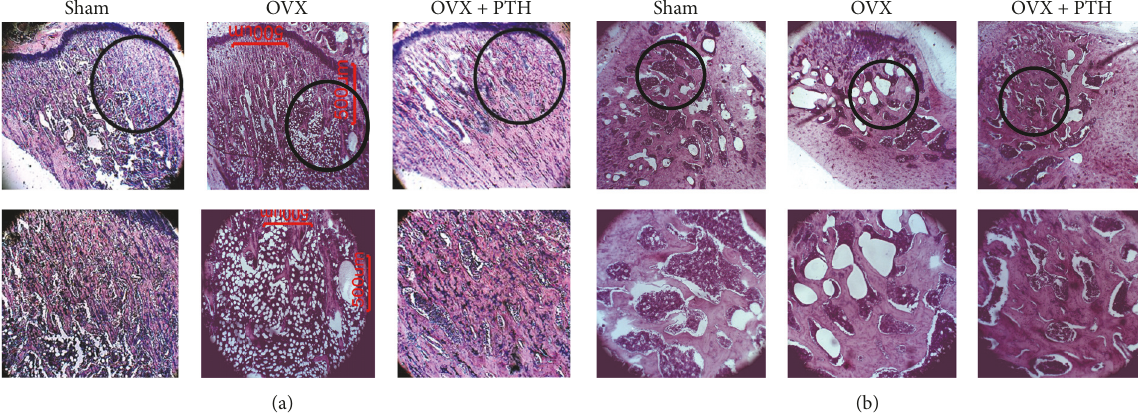
Figure 3: Prevention experiment reference measurements: examples of bone marrow cellularity histology (hematoxylin and eosin stain) of Sham, OVX, and OVX + PTH, treated with PTH at 6 weeks after operation: (a) bone marrow cellularity histology of tibiae bones; (b) bone marrow cellularity histology of femurs bones. OVX revealed a very high number of adipocytes and less dense trabecular bone compared with the Sham and PTH treated rats. Slides were visualized by Motic AE31 inverted microscope, magnification × 4/ × 10.